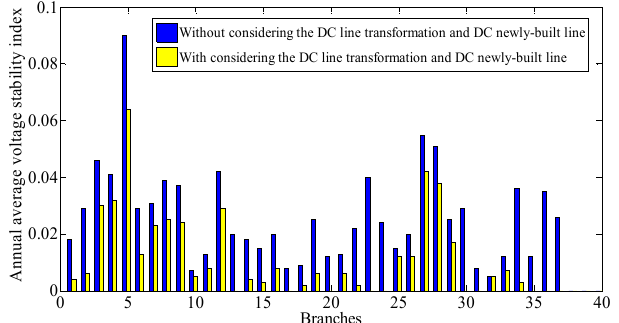
Figure 14. A contrast chart of the annual average voltage stability index with whether there is a consideration of the DC planning.